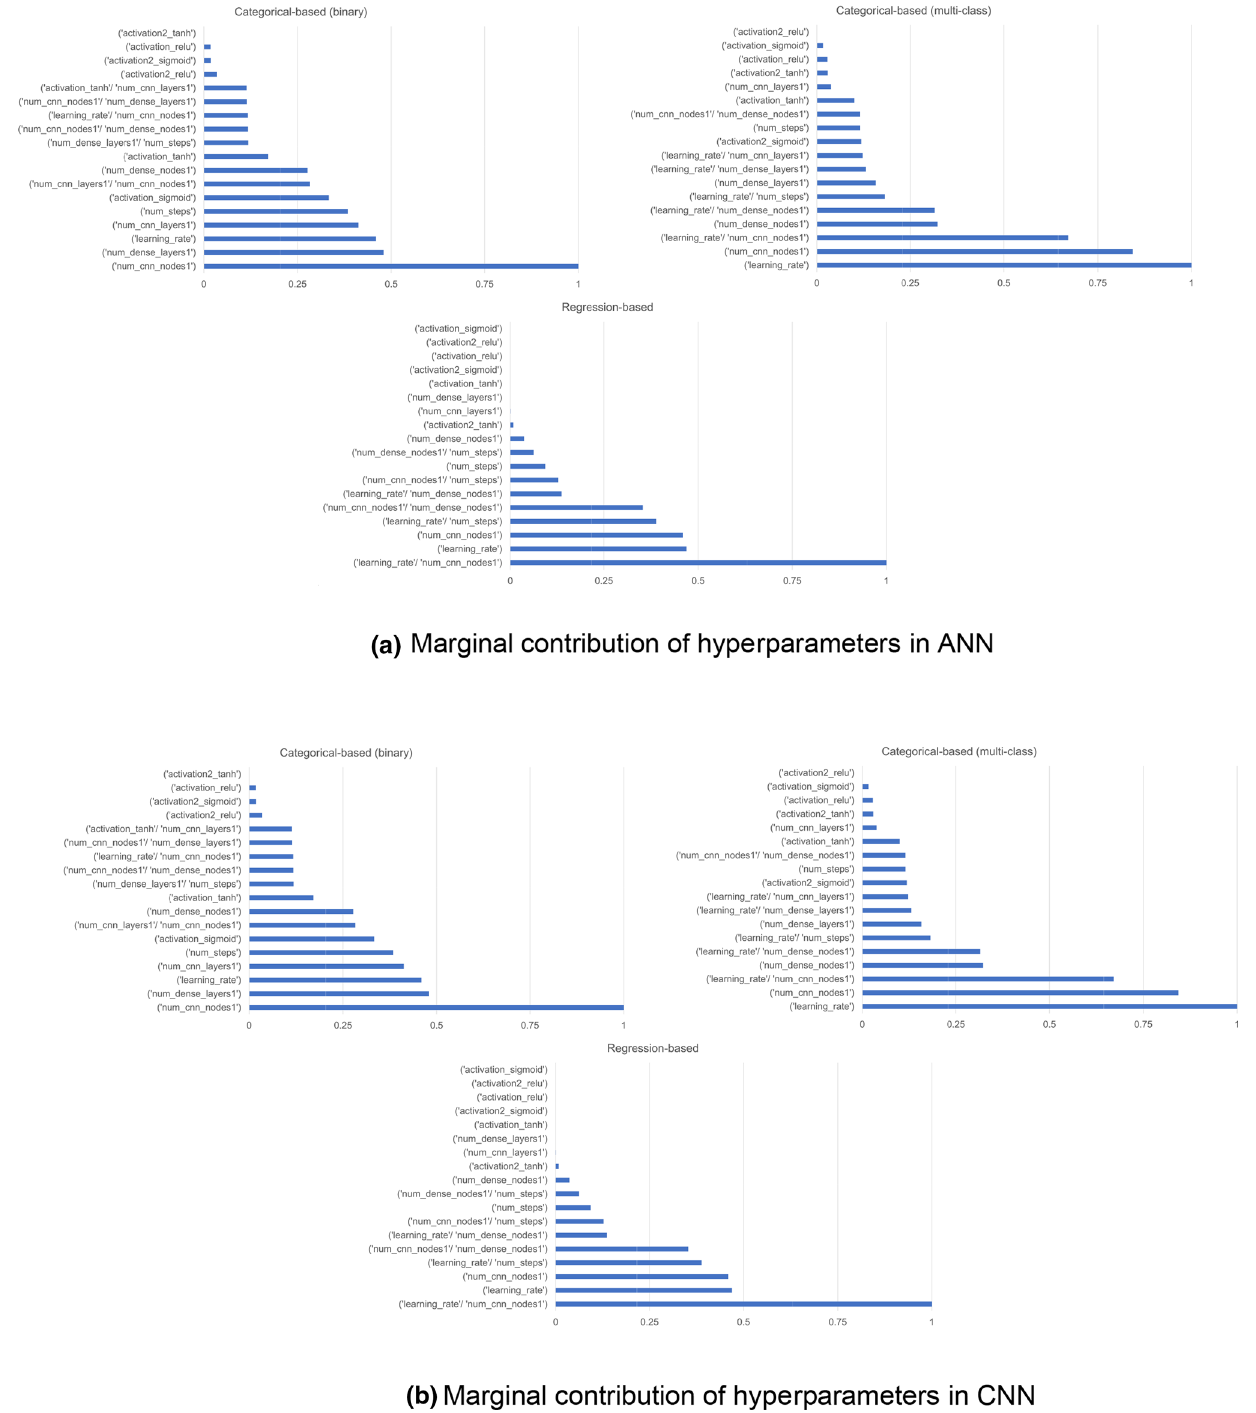
Fig. 9 Marginal contribution of hyperparameters in a ANN, b CNN, c CNN-GAF, and d